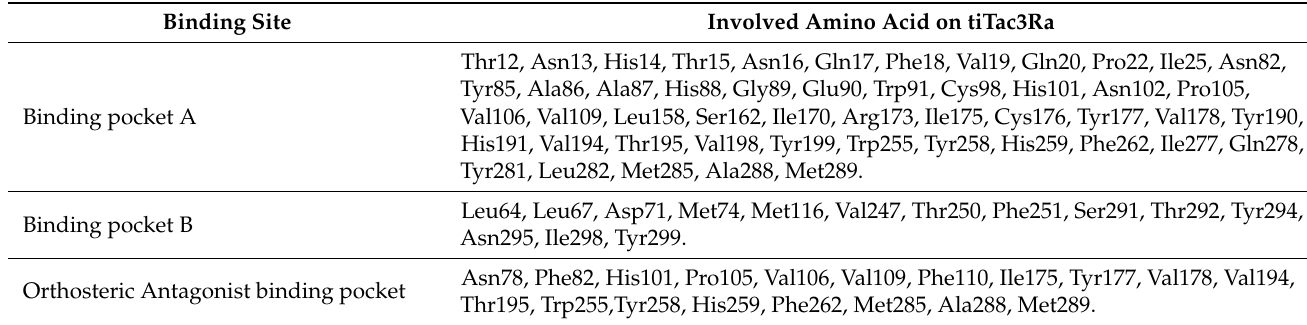
Figure 2. Binding pockets on tiTac3Ra: ( A ). Binding site A; ( B ). Binding Site B & Orthosteric Antagonist Binding Pocket (refer to Table 1: binding site map). The involved amino acids are in green (Site A), blue (Site B) and cyan (Orthosteric binding pocket). The site map shows the hydrophobic region (yellow), the hydrogen-bond donor (blue), and acceptor maps (red). Table 2 . List of Amino acids exposed to the Predicted Binding Sites on tiTac3Ra. (refer Figure 2) .